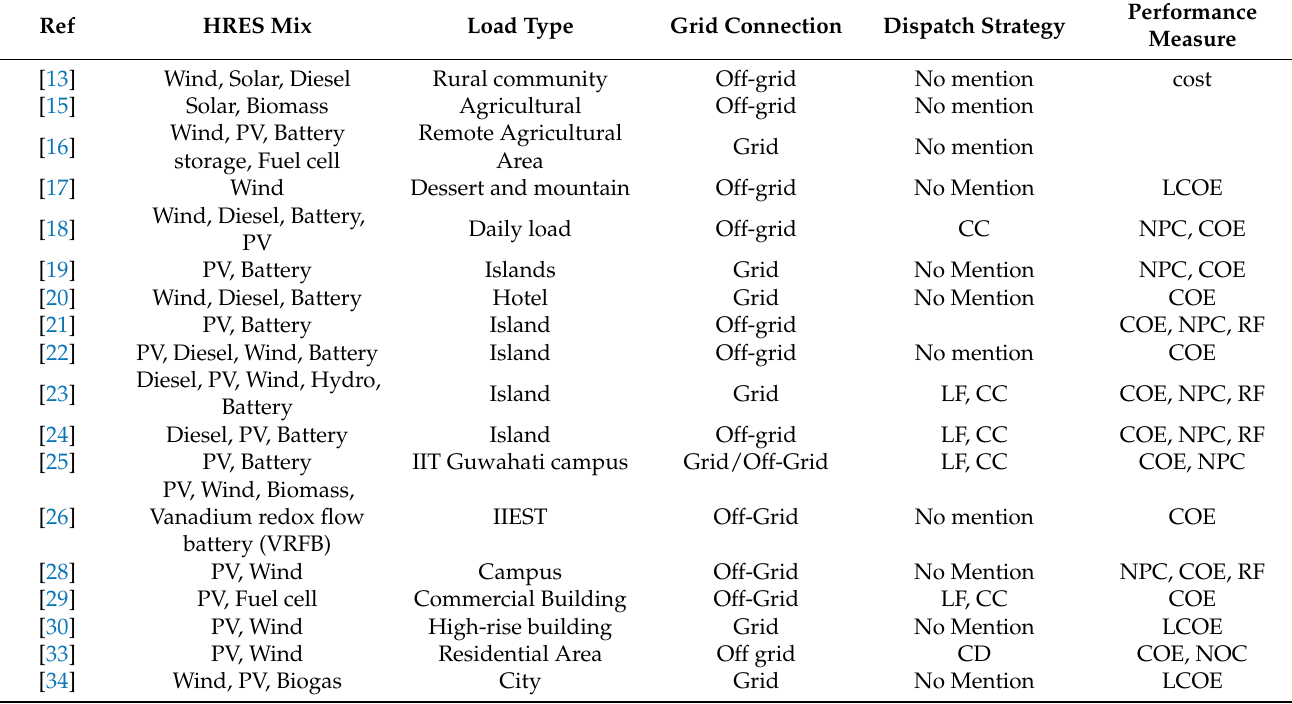
Table 1. Comparison of HRES designs from the